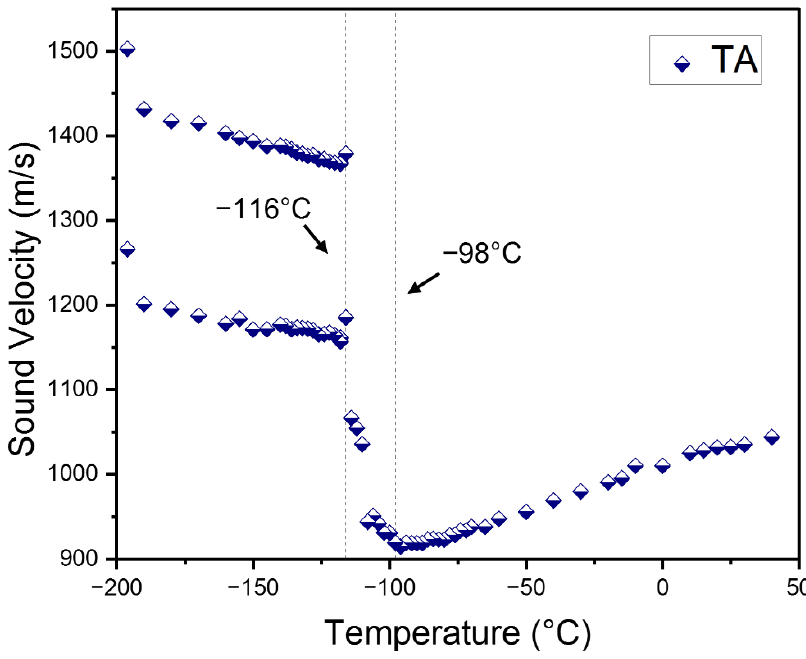
Figure 6. (Color online). Temperature dependences of the sound velocity of the TA mode. Phase boundaries are shown as vertical dotted lines along with the phase transition temperatures. Table 1. Comparison of sound velocities and elastic constants of several halide perovskites. MAPbCl 3 Parameters (This